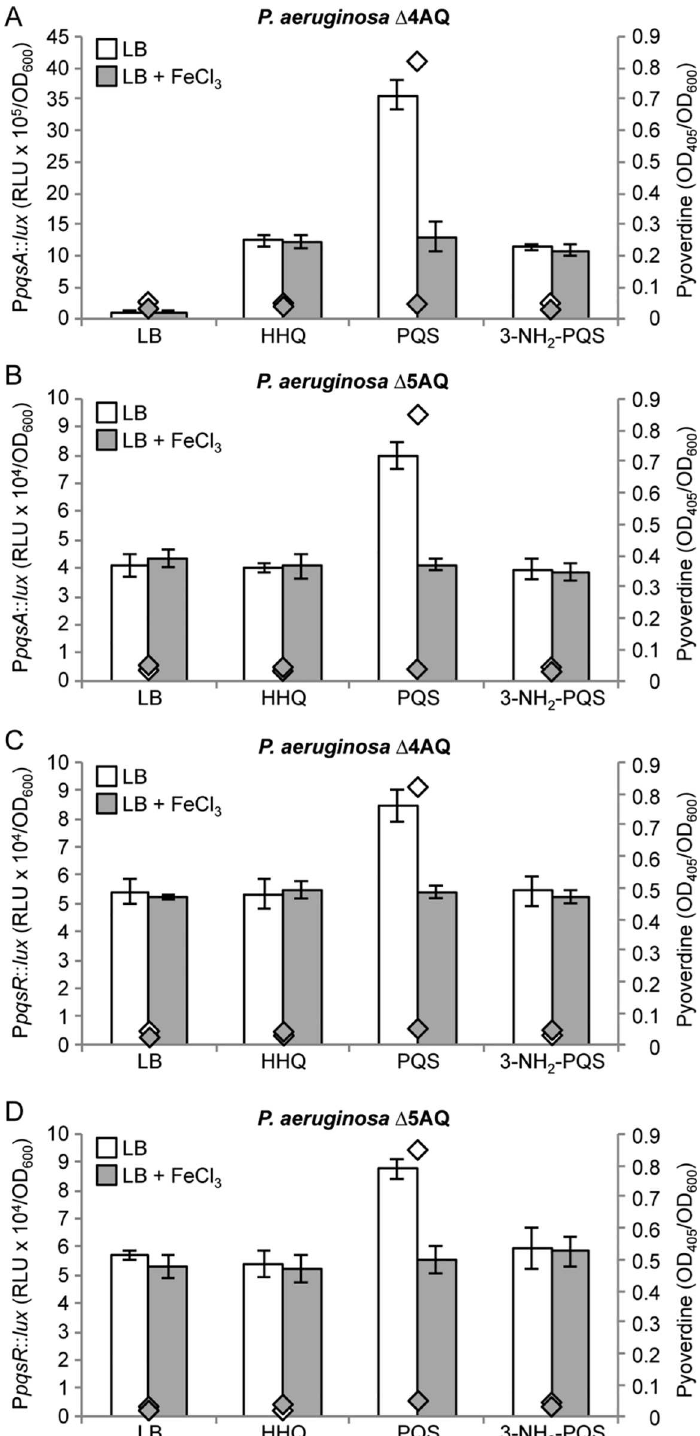
Fig 5. Interplay of HHQ, PQS, PqsR and iron in controlling P pqsA and P pqsR activity. Maximal promoter activity quantifiedin the indicatedstrains carrying the transcriptional fusions P pqsA :: lux ( A and B ) or P pqsR :: lux ( C and D ). Strains were grown in LB or in LB supplemented with 40 μ M HHQ, PQS or 3-NH 2 - PQS, as indicatedbelow the graphs, in the absence (white bars) or presence (grey bars) of 100 μ M FeCl 3 . Diamondsindicate the pyoverdinelevels in the absence (white diamonds)or in the presence